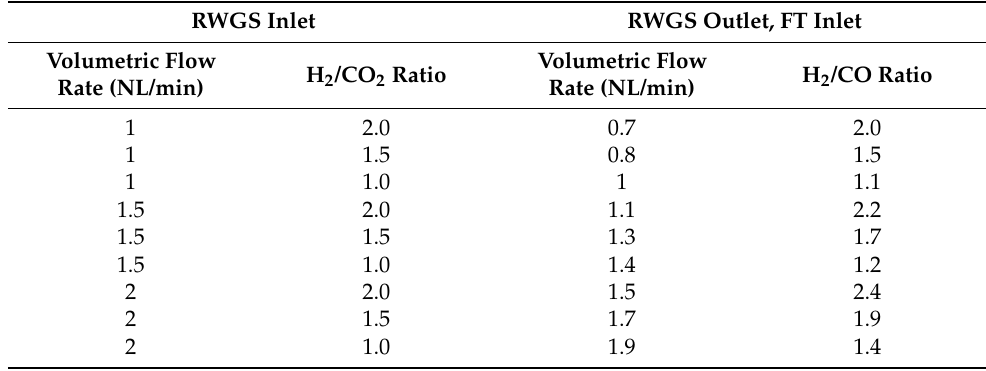
Figure 4. RWGS outlet gas composition as a function of the H 2 /CO 2 ratio after the removal of water. GHSV: 35,800 h −1 ; pressure: 6 bar; temperature: 850 °C. Some methane was always produced in the RWGS reactor as well. This is most likely caused by methanation, which is favored in the lower temperature regions inside the re- actor, namely the top of the reactor, where the gas enters the reactor at a cooler tempera- ture and the furnace heating is not as powerful. The lower temperature causes the methanation reaction to become more favorable, lowering the selectivity towards CO. The amount of methane produced in the RWGS reactor is dependent on the feed gas compo- sition, GHSV, temperature and the catalyst used, with the feed gas composition being the most important factor. The methane selectivities of the RWGS reaction with the studied